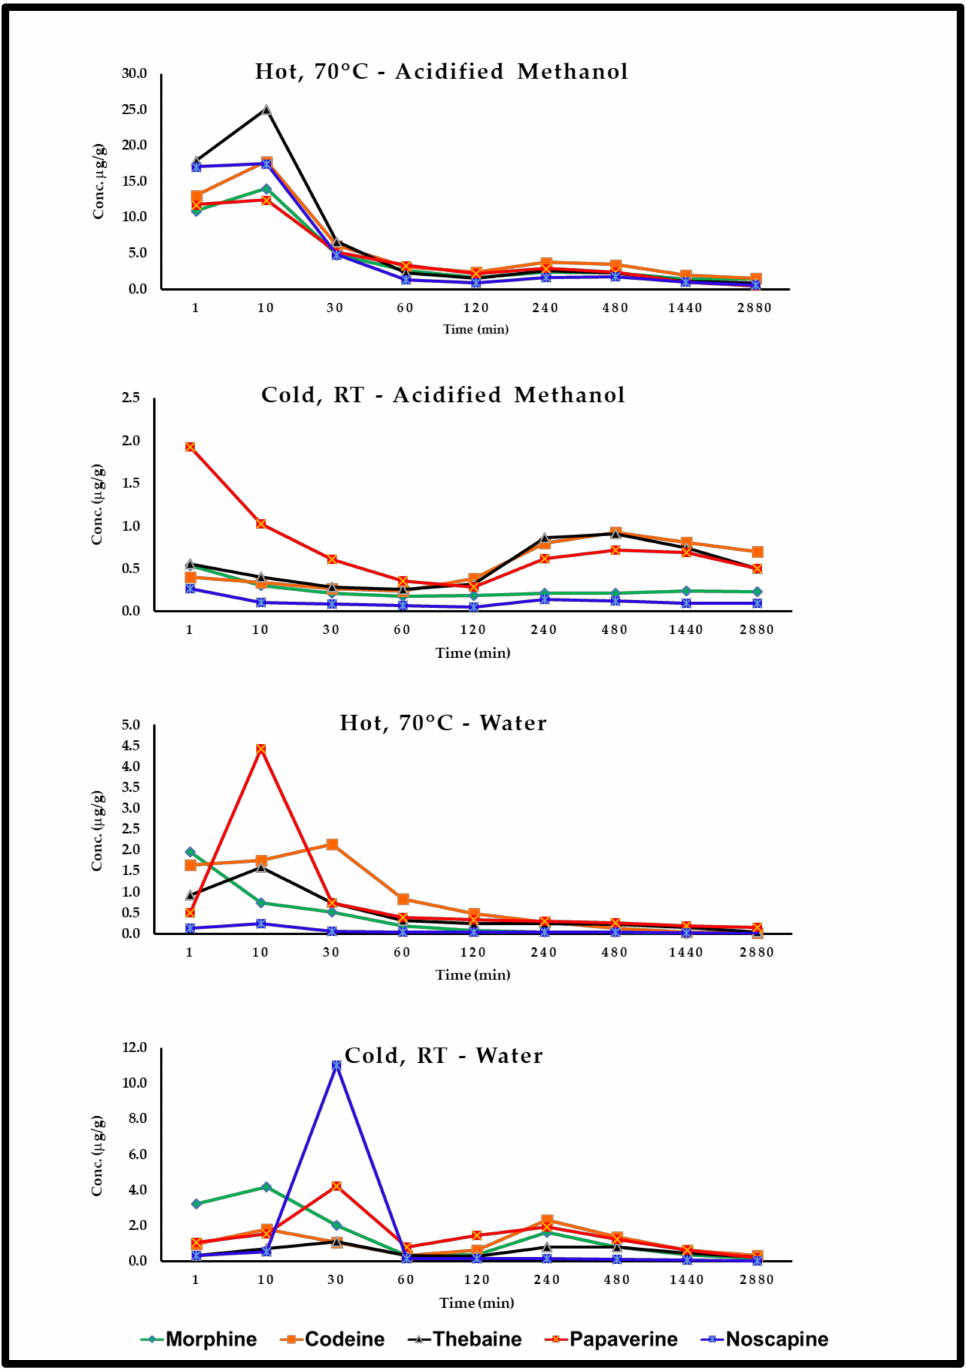
Figure 7. Change in alkaloid content ( µ g/g) during washing at different conditions and time intervals. Very low levels of OAs were detected in studied poppy seed samples using the current analytical methodology. This study confirms that poppy seed morphine or other OAs originate predominantly from external contamination. This was further confirmed